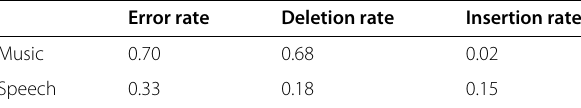
Table 3 Error, deletion, and insertion rate evaluated on TVSM-test dataset by T1 methods. The metrics are calculated via sed_eval